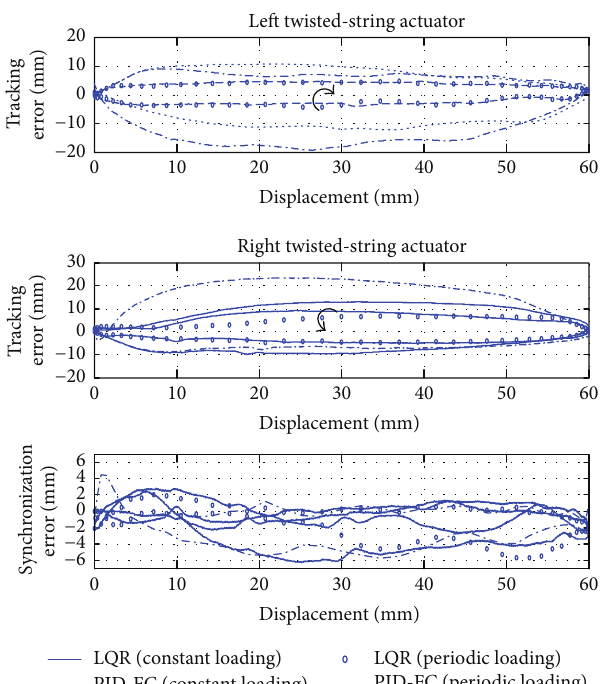
Figure 17: Comparison of tracking and synchronization errors of PID-FC and LQR-FC controlled results with 500g fixed loading and periodic loading.